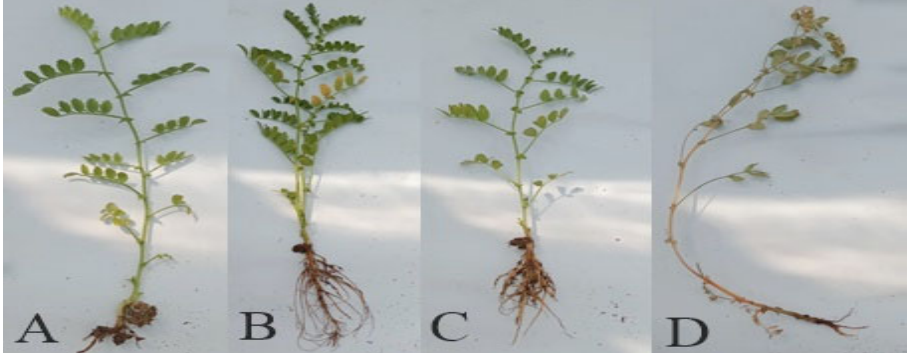
Figure 12. Visual assessment of wilting and yellowing. Control ( A ), seeds primed with NPs ( B ), Seeds primed with 500 mg/L nanoparticles and sown in fungus ‐ contaminated soil ( C ). Seeds sown in fungus ‐ contaminated soil ( D ).